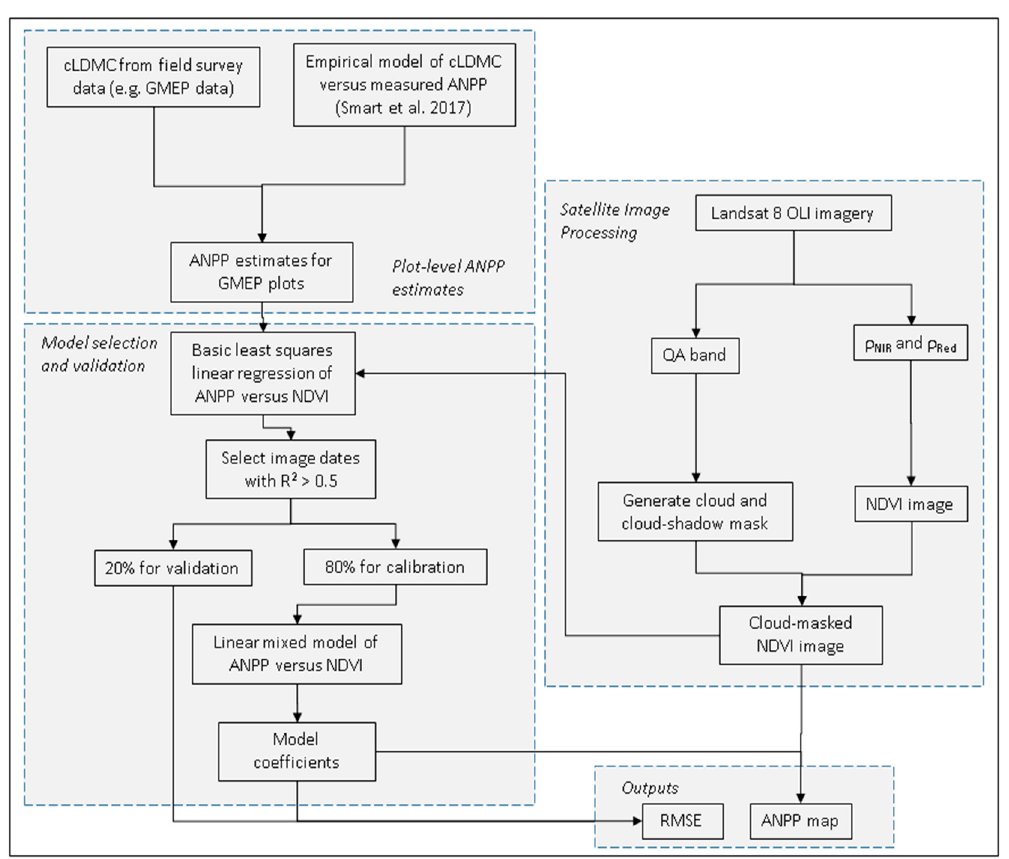
Figure 2. Methodological framework for producing high-resolution regional scale ANPP maps from ground-based measurements and EO data. GMEP is the Glastir Monitoring and Evaluation Program and cLDMC is cover-weighted Leaf Dry Matter Content.